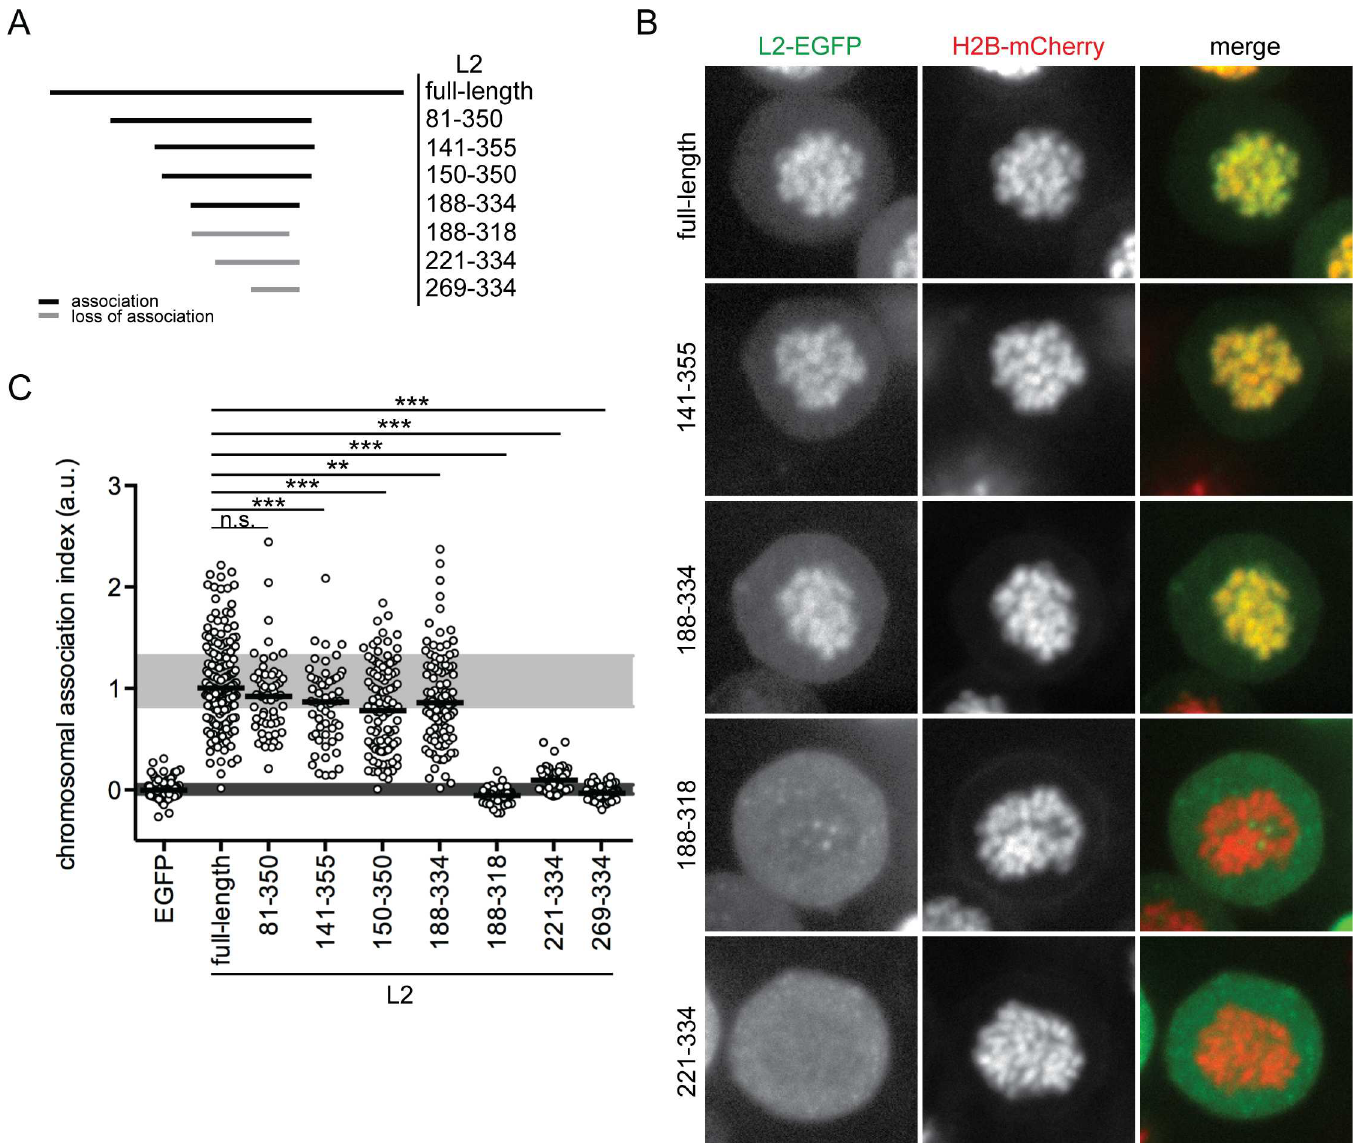
Fig 3. Chromosomal association of bilateral truncations of HPV16 L2. (A) Overview of the bilaterallytruncatedHPV16 L2-EGFP that were assayed for chromosomal association(numbers indicate the amino acid residues). (B) Images of full-lengthand selectedfragments of HPV16 L2-EGFP (left, green), H2B-mCherry (center, red), and merges (right, merge) are depictedfor representativecells (the remainingconstructs are shown in S3 Fig). (C) The chromosomal associationindicesof the N- and C-terminally truncatedversions of L2-EGFP are plotted as in Fig 2D. Statistical significances (two-tailed Student’s t-test) relativeto full-lengthHPV16 L2-EGFP were determined(n.s. = not significant, ** P < 0.01, *** P < 0.001).